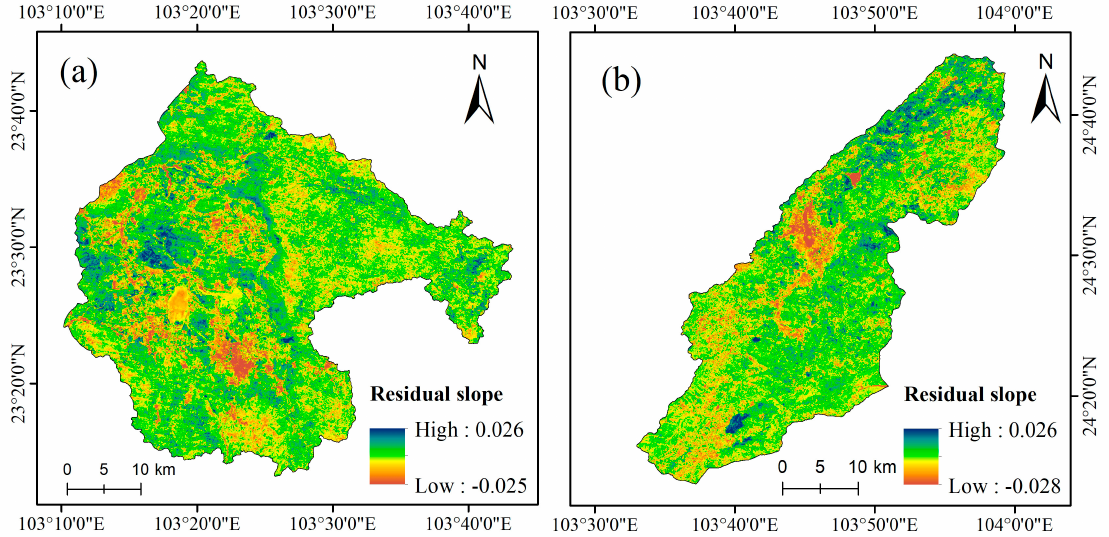
Figure 10. The change trend of human-induced residual of vegetation changes from 1988 to 2016 in: ( a ) Nandong; and ( b ) Xiaojiang watersheds.